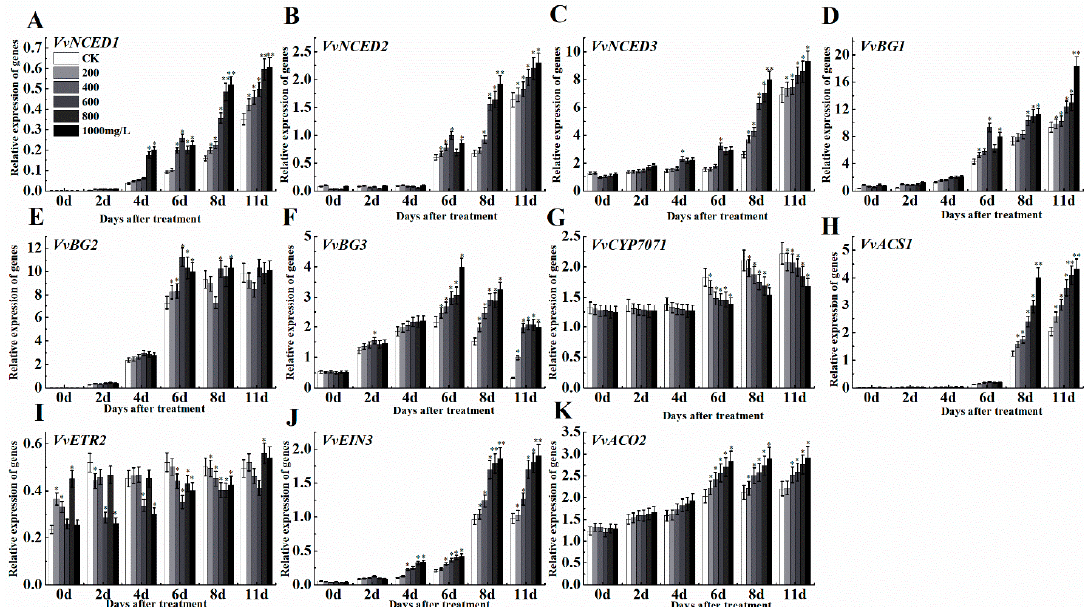
Figure 6. Effect of ethephon on ABA and ethylene-related genes expression in grape. ABA metabolism-related gene expression levels of ( A ) VvNCED1 , ( B ) VvNCED2 , ( C ) VvNCED3 , ( D ) VvBG1 , ( E ) VvBG2 , ( F ) VvBG3 , ( G ) VvCYP707A . Ethylene metabolism-related gene expression levels of ( H ) VvACS1 , ( I ) VvETR2 , ( J ) VvEIN3 and ( K ) VvACO2 . Ethephon was used in different concentrations (200, 400, 600, 800, and 1000 mg/L) and in a time course experiments (2, 4, 6, 8, and 11 days). Values are means ± SD of five biological replicates. * Significant differences compared with the control (water-treated fruits) sample at p < 0.05, ** Significant differences compared with the control (water-treated fruits) sample at p < 0.01 using Student’s test.